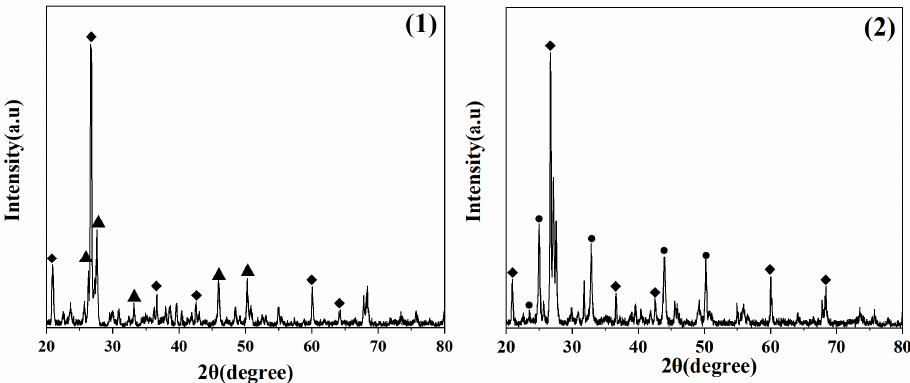
Figure 7. XRD pattern of the processed stone sample. (1) is an aragonite-treated sample, and (2) is a vaterite-treated sample, ▲ —Aragonite, ●—Vaterite, ◆ —Silica.